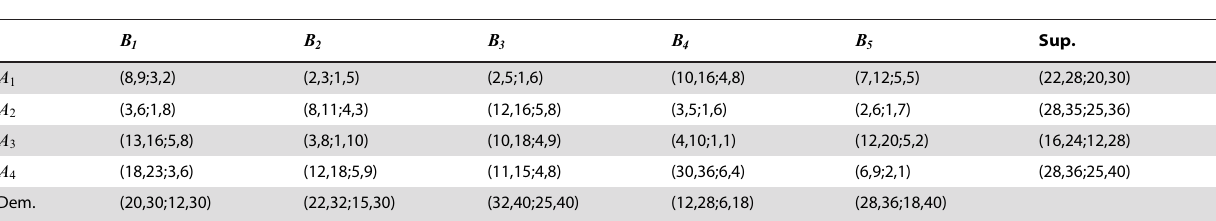
Table 1. Data of the